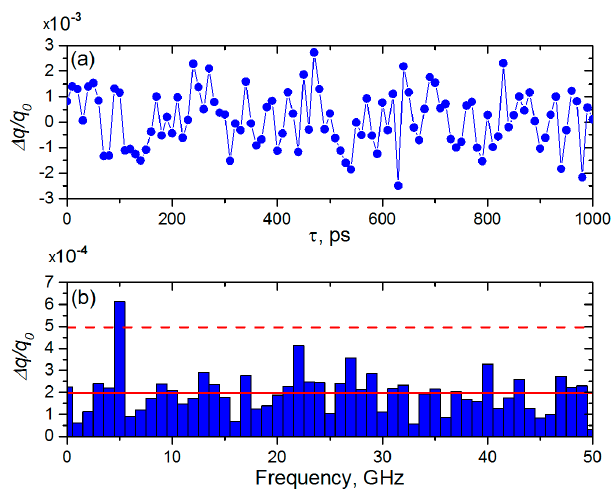
Figure 9. ( a ) Simulation of the signal ∆ q ( τ )/ q 0 and ( b ) Fourier transform of this signal. The average value of all Fourier components is indicated by red line. The dashed red line corresponds to level of 3 σ above the average value, where σ is a standard deviation and is determined from the distribution of Fourier components.